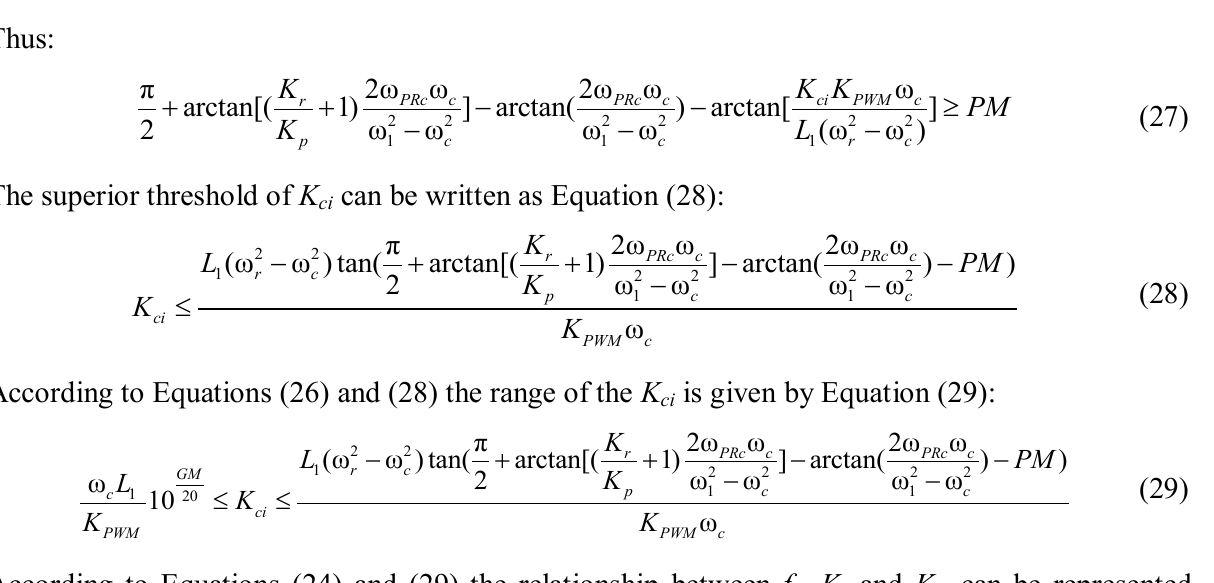
Figure 10. Relationship between f